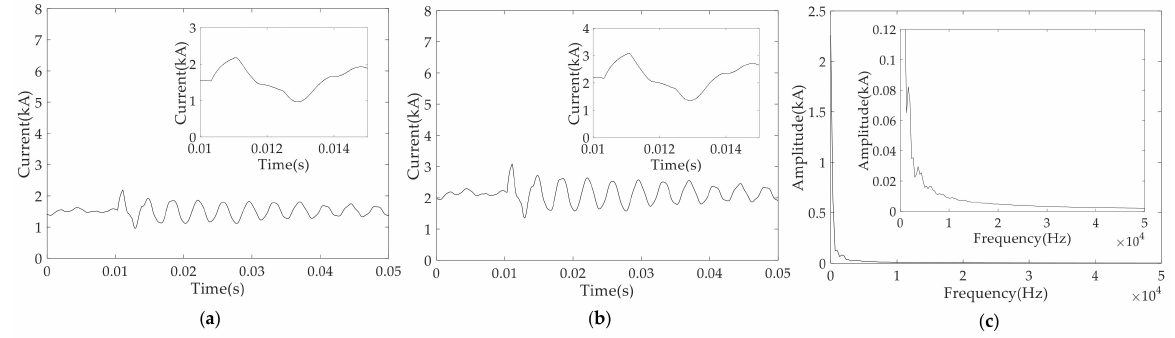
Figure 6. MMC-HVDC system PGF characteristics. ( a ) Current waveform; ( b ) current line mode component waveform; ( c ) spectrum